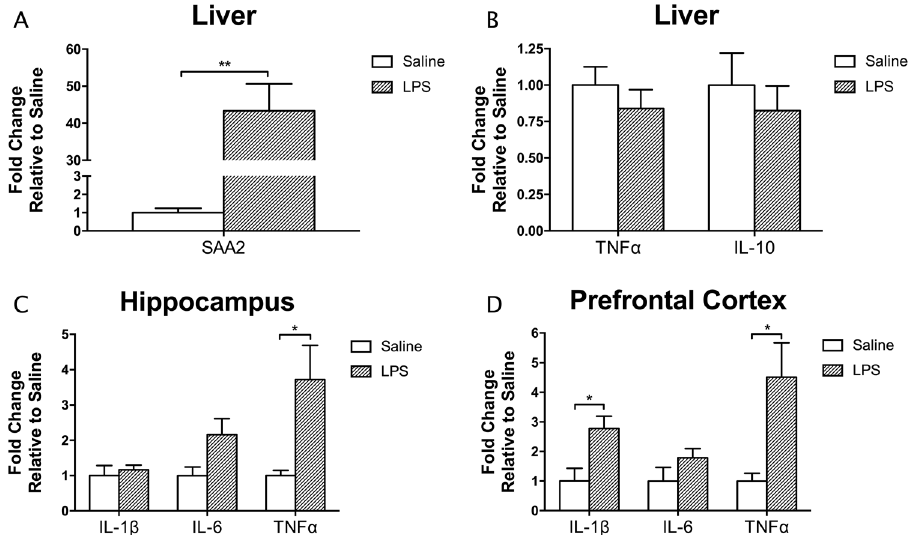
Figure 3. A single injection of LPS increased the expression of liver SAA2 ( A ), but did not alter liver cytokine expression ( B ) after 24 h. On the other hand, increased expression of inflammatory cytokines in the brain at this timepoint was evident after endotoxin administration. This was more pronounced in the prefrontal cortex ( D ), which had significantly increased expression of TNFα and IL1ß in the LPS group, compared to the hippocampus ( C ), where only TNFα expression was elevated. Data presented as mean + SEM. * p < 0.05; ** p <